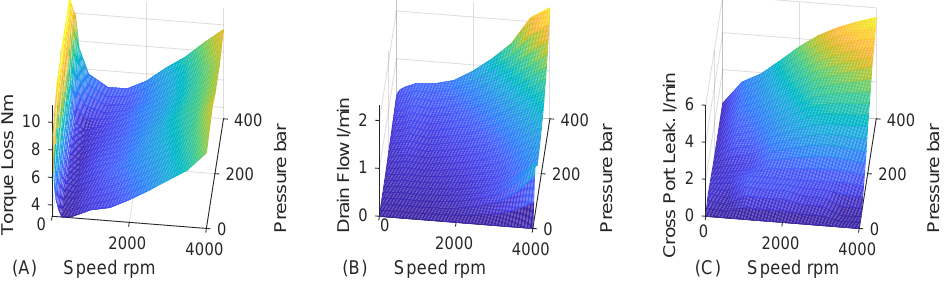
Figure 6. Losses estimated from [59] with D = D ref = 27.75 ccm. ( A ) A4FM torque loss; ( B ) A4FM drain flow; ( C ) A4FM cross port leakage